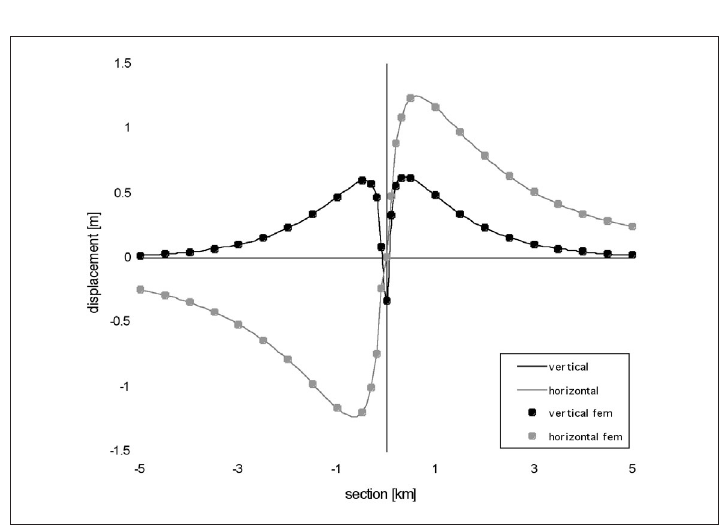
Fig. 2. Comparison between the theoretical deformation field and that found with the FEM model for a tensile dislocation in a homogeneous and elastic half-space. Dots indicate the FE solution, solid lines the analytical solu- tion (grey colour for horizontal displacement and black colour for vertical displacement). The agreement between the two sets of solution is evident. For the geometrical parameters see table I.